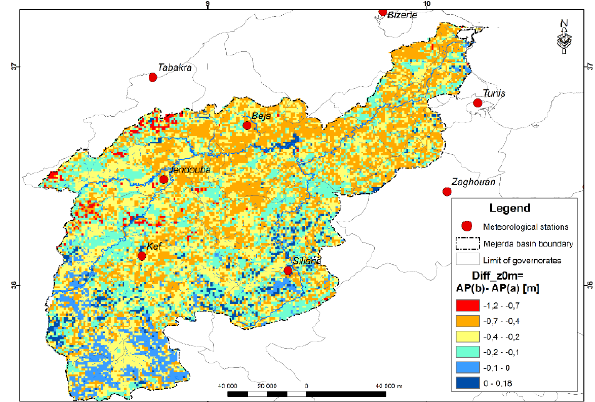
Figure 7. Map of the difference between roughness heights for momentum transfer z 0m estimated using two approaches: z 0m estimated from empirical equation (b) minus z 0m estimated from land use classification (a) in Medjerda basin on 6 May 2010. Figure 8 highlights that the greater change of AET, which varies between [-1, -2 mm day -1 ], is observed for the forestlands. All the other land cover except water bodies are characterized by a variation which lays between [-0.5, 0.5 mm day -1 ]. In general, Figure 8 suggests a positive trend between actual evapotranspiration (AET) changes and roughness for momentum height (z 0m ) changes: AET decreases as z 0m decreases.